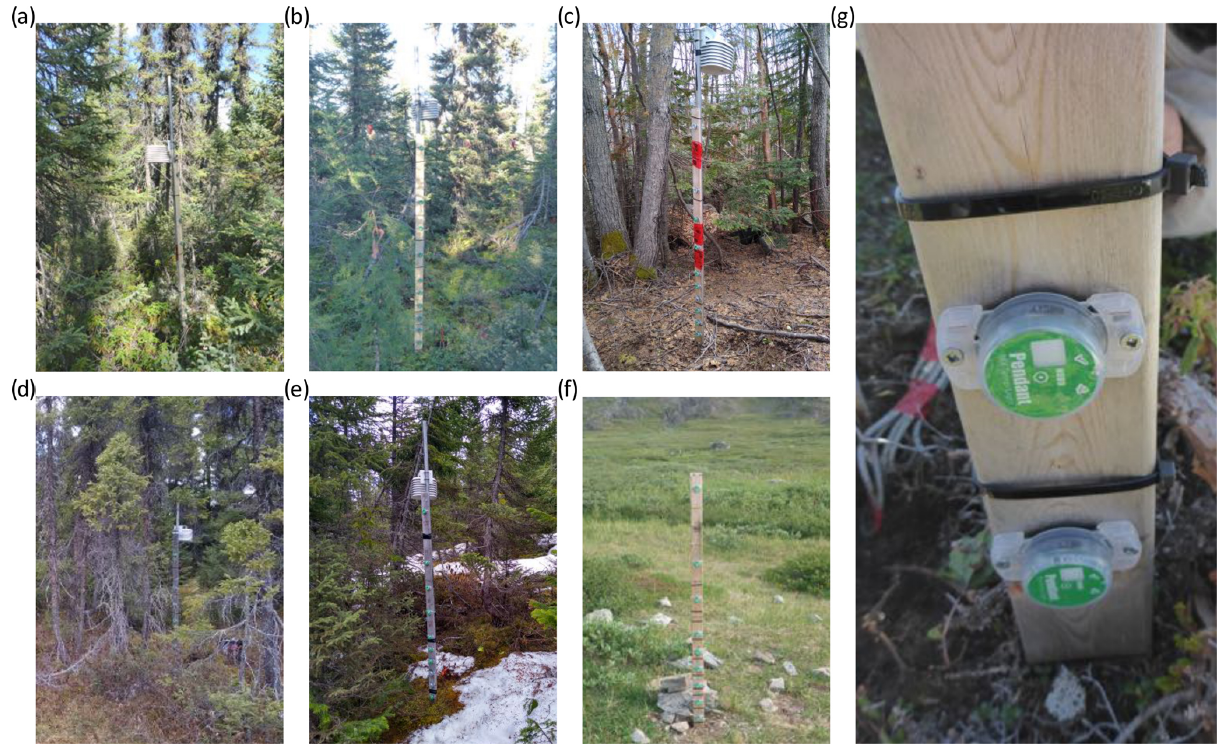
Figure 3. Field photos of all SCLT measurement sites for 2018–2019 and (g) a close-up of logger installation onto stake. These include